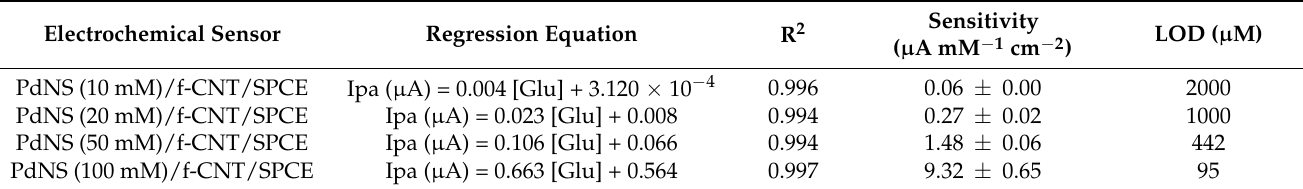
Table 1. Summary of the analytical parameters of the developed non-enzymatic electrochemical glucose sensors for glucose sensing in a neutral environment (PBS, pH